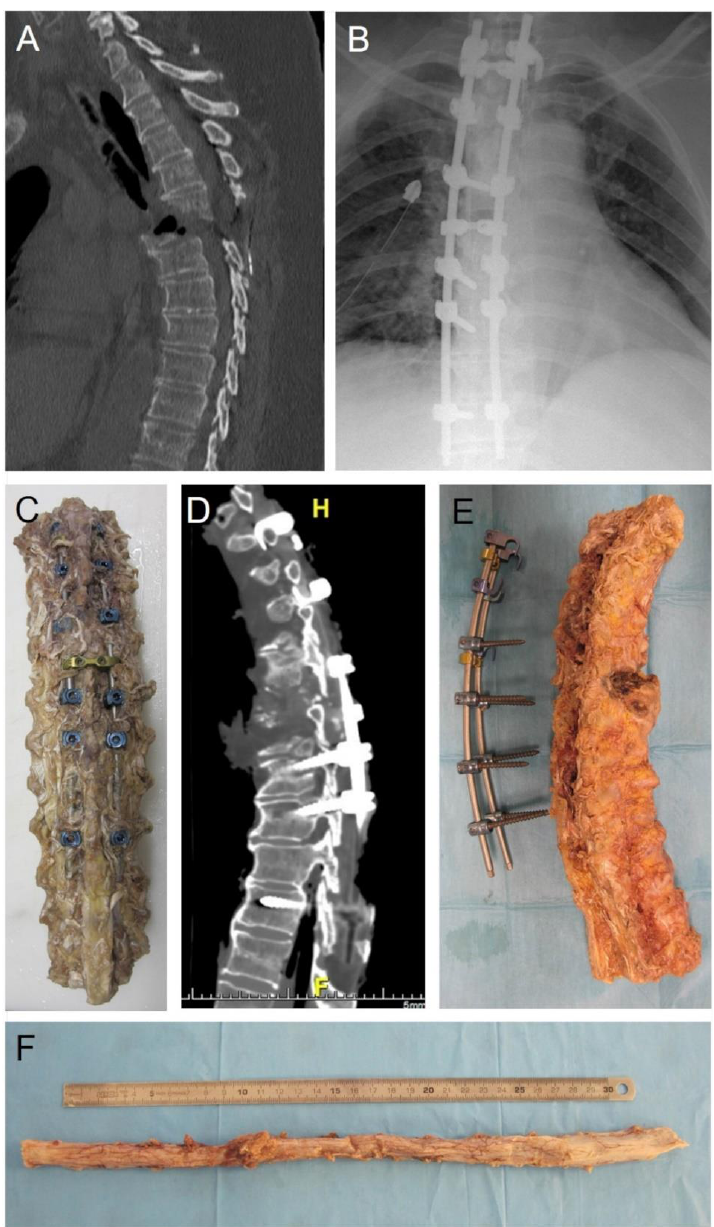
Figure 4. Spine trauma. ( A ) in vivo pre-surgery computed tomography. ( B ) in vivo post-surgery radiography. ( C ) sampling of the spine segment. ( D ) post-autopsy computed tomography of the sampled spine. ( E ) removing of pedicle screws. ( F ) general view of the spinal cord, with evidence of hemorrhagic infiltration of the dural sac. (H: Head; F: